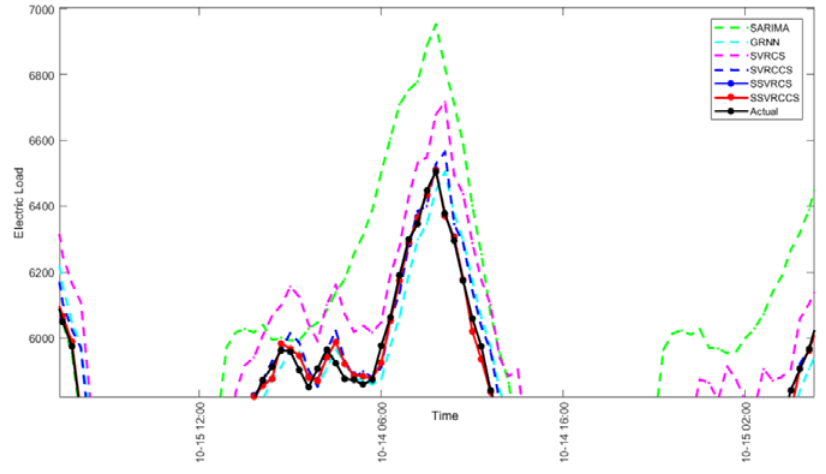
Figure 6. The enlargement comparison of Peak 2 from the compared models for Example 1. Energies 2018 , 11 , x 13 of 21